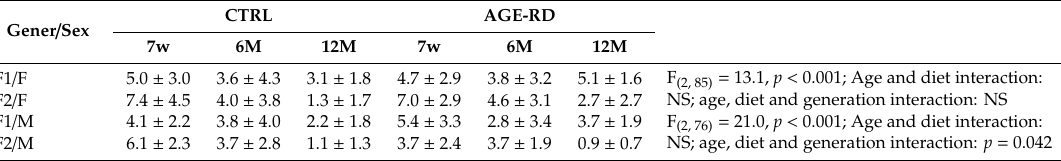
Gener, generation; CTRL, o ff spring of F0 dams consuming standard diet; AGE-RD, o ff spring of F0 dams consuming a diet rich in advanced glycation end products; 7w, 7-week-olds; 6M, 6-month-olds; 12M, 12-month-olds; F, females; M,